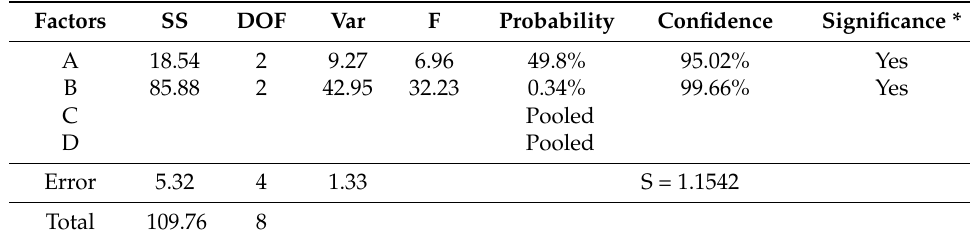
Table 3. Analysis of Variance for the S / N Ratios.